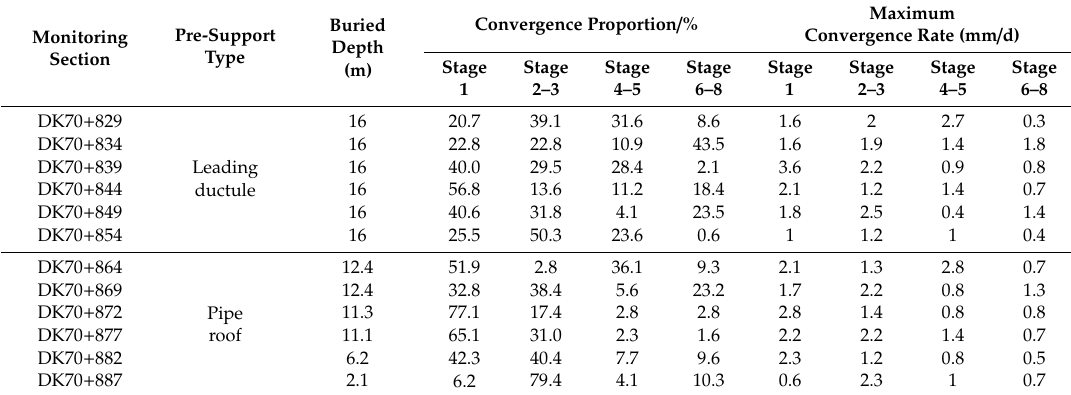
Table 5. Convergence proportion and maximum convergence